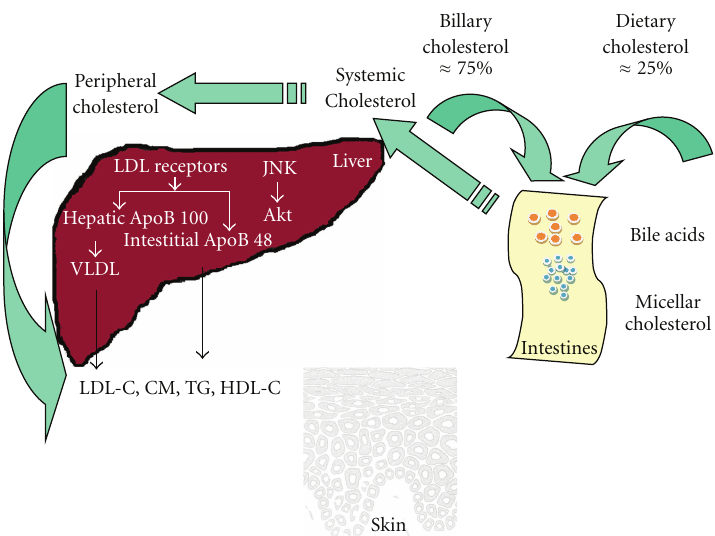
Figure 1: Cholesterol tra ffi cking in human organism. CM: chylomicrones, HDL-C: high-density lipoproteins cholesterol, LDL-C: low- density lipoproteins cholesterol, VLDL-C: very low-density lipoproteins cholesterol, TG: triglycerides, JNK: Janus-family tyrosine kinase, and Akt: kinase Akt. The figure is adapted after permission from [13]. The complete electronic version of this article can be found online at: